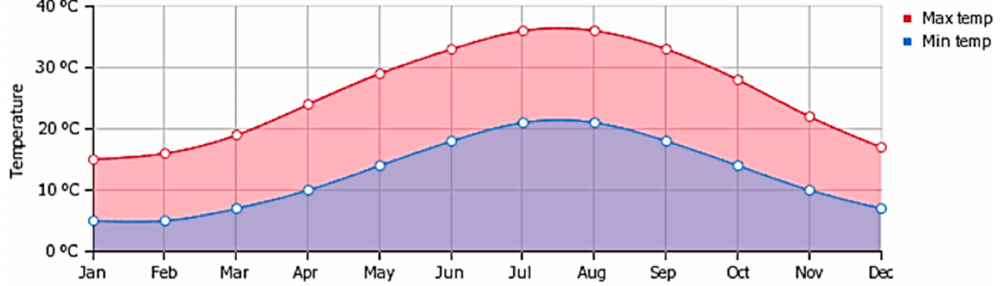
Figure 9. The mean monthly temperature of North-Cyprus [33].